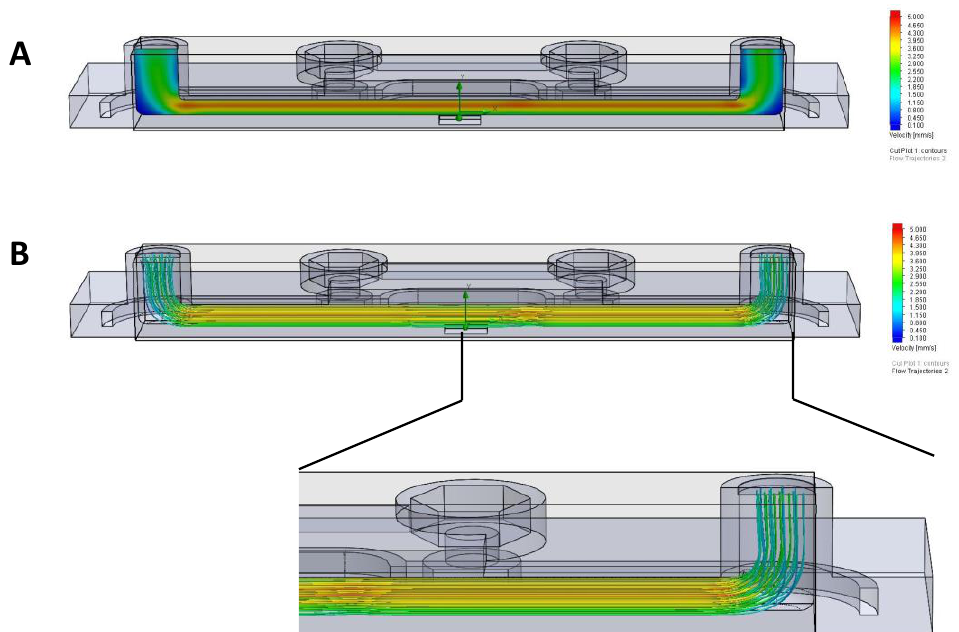
Figure 4. The 3D TripleB slides demonstrate the presence of continuous laminar flow. To model the flow inside of the microfluidic slide, the CFDs for the 3D designed slide were generated, which shows ( A ) the range of velocities as measured from 3 different positions in the bottom chamber of the slide ( B ) and the presence of unidirectional laminar flow in the TripleB slides.